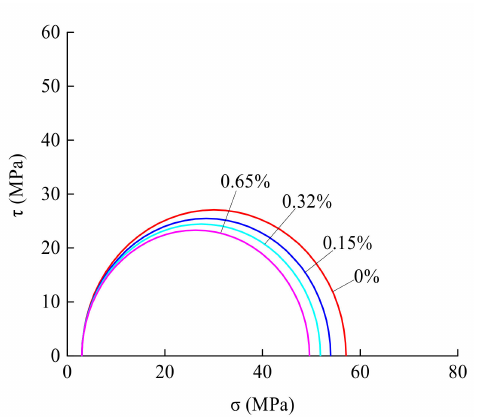
Figure 4. Coal sample Mohr stress circle under di ff erent water content conditions.